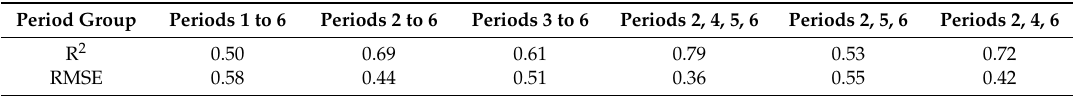
Table 4. Estimating results for monitoring models based on different multi ‐ temporal combination groups.